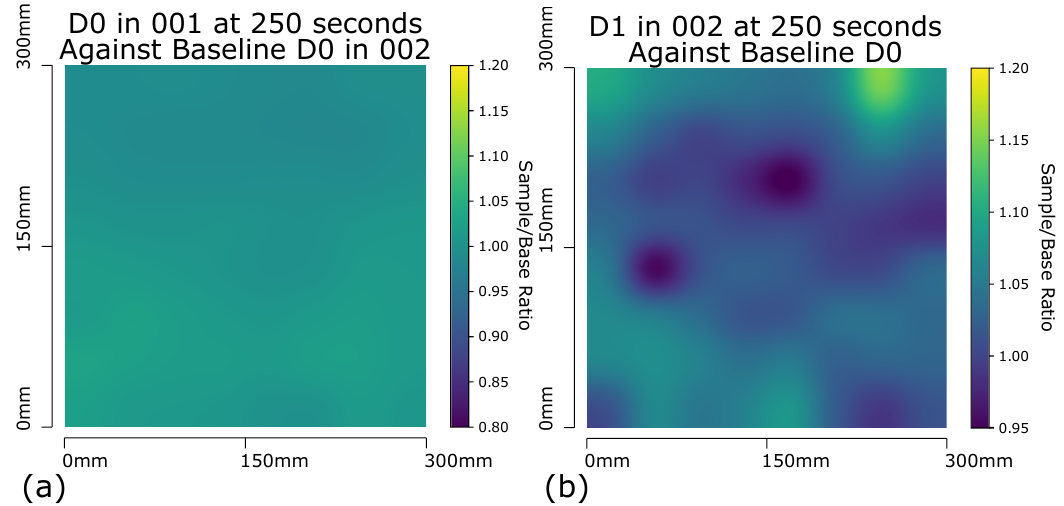
Figure 8. ( a ) Panel D0 run 001 at 250 s with Gaussian interpolation applied to RTD array captured data, each probe compared against corresponding baseline probe on D0 sample run 002. ( b ) Panel D1 at 250 s with Gaussian interpolation applied to RTD array captured data. Each probe compared against corresponding baseline probe on D0 sample at same time and temperature.